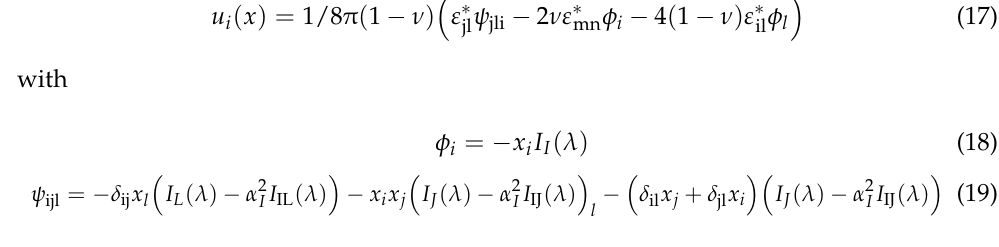
Table 4. Comparison of the residual stress inside the α -Al(Mn, Fe)Si precipitate with sphere computed by Equation (9) under cold-rolling condition ( ε 0 Equivalent stress, σ eqv , is computed by Equation (16). ε 0